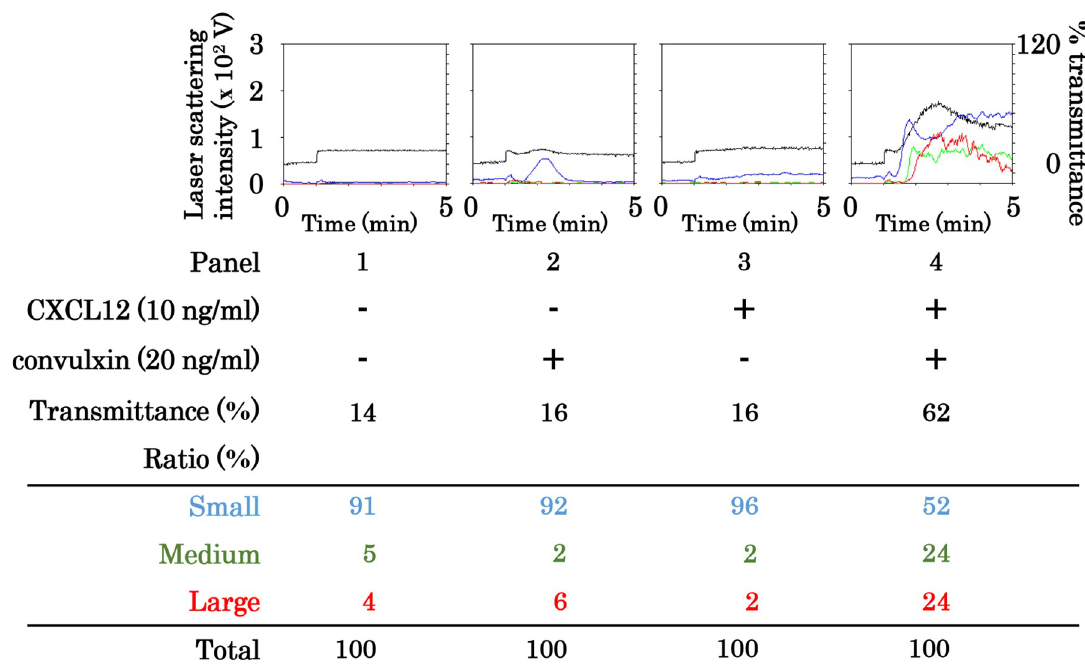
Fig 3. Effect of simultaneous stimulation with convulxin and CXCL12 in low doses on platelet aggregation. PRP was simultaneously stimulated by 20 ng/ml of convulxin and 10 ng/ml of CXCL12 for 5 min. The reaction was terminated by the addition of ice-cold EDTA (10 mM) solution. The black line indicates the percentage of transmittance of each sample (isolated platelets recorded as 0%, and platelet-poor plasma recorded as 100%). The blue line indicates small aggregates (9–25 μ m); green line, medium aggregates (25–50 μ m); red line, large aggregates (50–70 μ m). The lower panel presents the distribution (%) of aggregated particle size as measured by